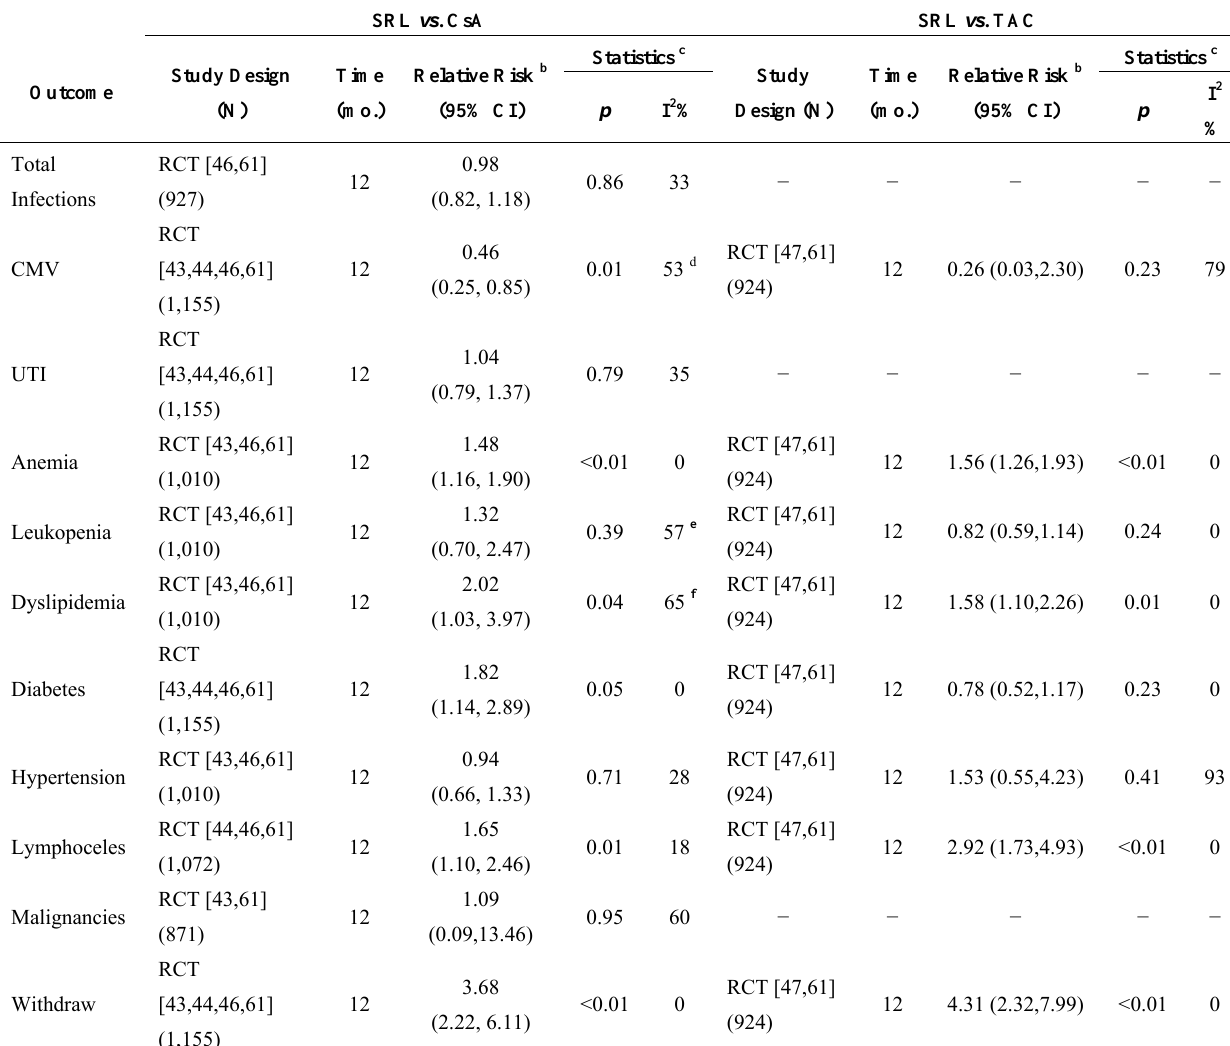
Table 4. Meta-analysis results of outcomes reported by studies comparing SRL vs. CsA or TAC a